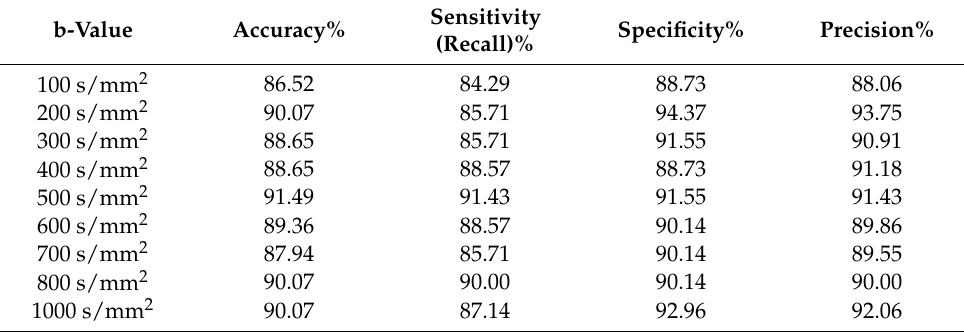
Table 2. Performance of AlexNet at 9 b-values using 141 ADC maps.